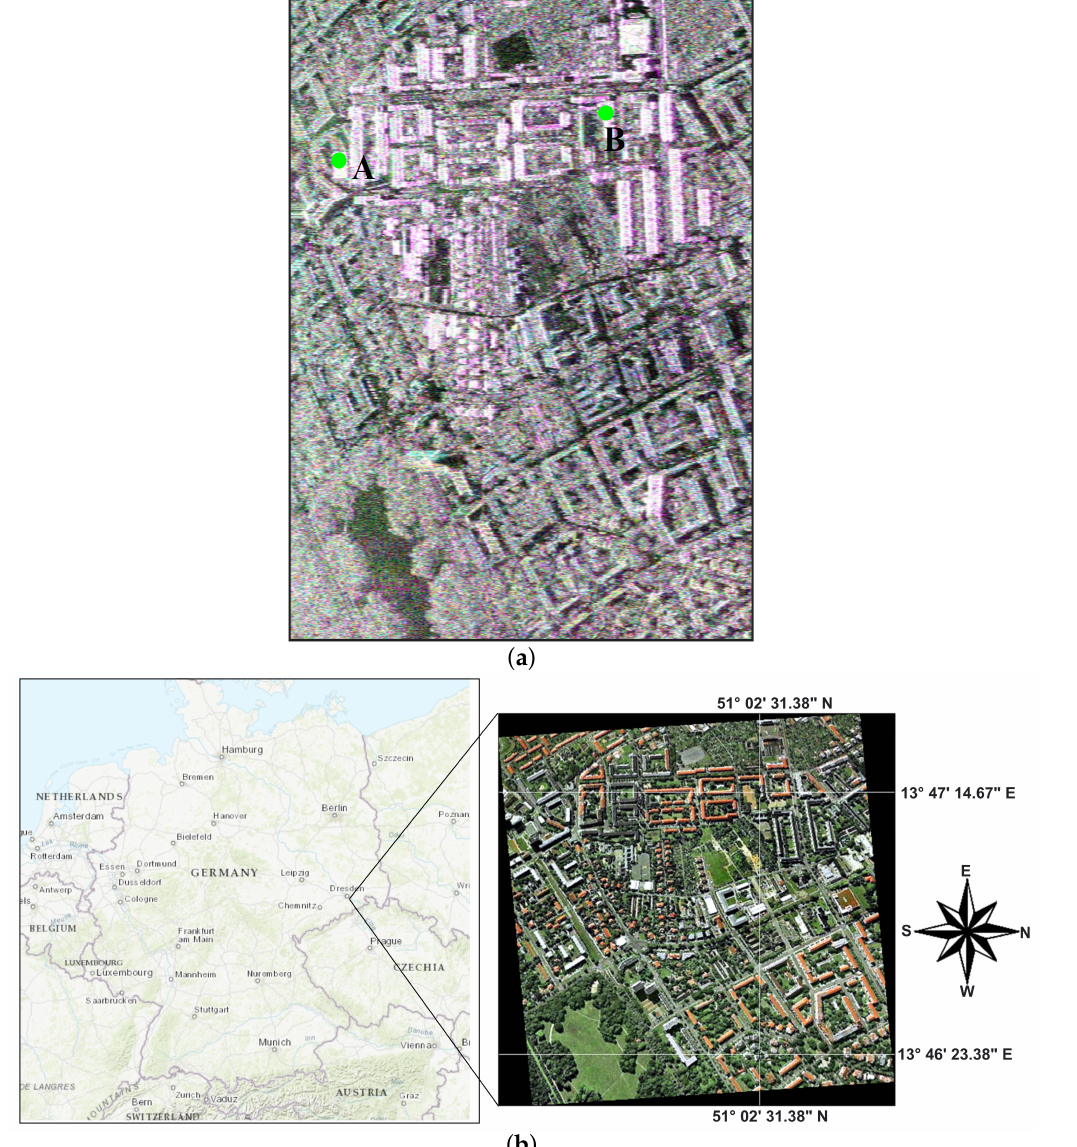
Figure 2. Information about the data set and the study area in Dresden, Germany. ( a ) The Pauli color composite of the polarimetric ESAR master image provided by the German Aerospace Center (DLR). ( b ) Location of the study area on the map of Germany (left) and the georeferenced optical image of the test area (right) (courtesy of Google